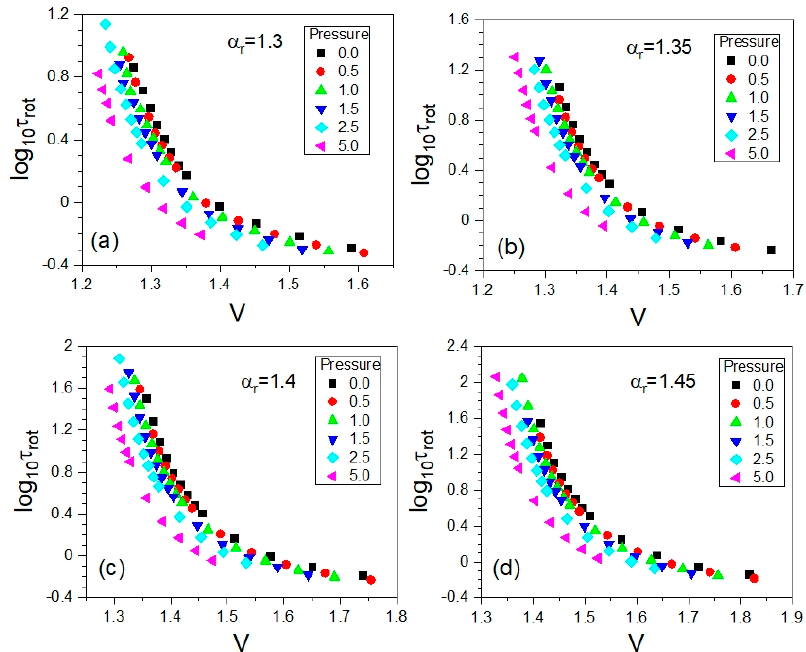
Figure A1. Plots of the isobaric dependences of translational relaxation times τ on the particle num- ber volume V for different anisotropy aspect ratios α r in the supercooled liquid state in the GB model. In the separate panels, there are the cases shown for the different anisotropy aspect ratios α r : ( a ) 1.30, ( b ) 1.35, ( c ) 1.40, and ( d ) 1.45, respectively.